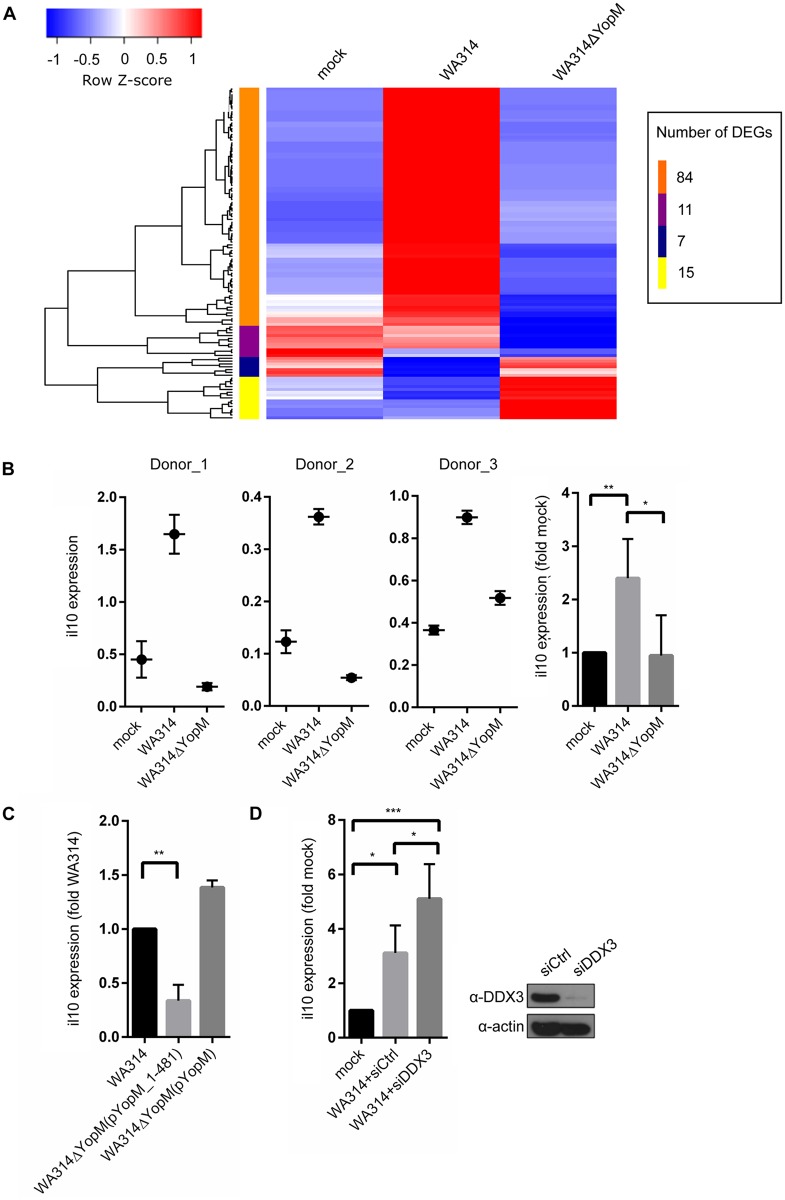
YopM upregulates IL-10 expression in Yersinia infected human macrophages.
A) Heatmap of expression values of differentially expressed genes (DEGs) in human macrophages not infected (mock) or infected with WA314 or WA314ΔYopM. Duplicates (two different donors) of primary human macrophages were infected without (mock) or with Yersinia enterocolitica WA314 or WA314ΔYopM for 6 h. Total RNA was prepared from each sample and subjected to RNA-seq. The scaled expression of each set of replicates, denoted as the row Z-score, is plotted in a red-blue color scale. Red indicates high and blue indicates low expression. Only genes with an absolute log2-fold change greater or equal 2 and p-value smaller or equal 0.01 are shown. These genes were hierarchically clustered (complete linkage) according to their expression profiles. The resulting distinct sets of genes are indicated by the orange-, purple-, blue- and yellow color bar. The number of DEGs in each cluster is indicated. B) Analysis of IL-10 expression in Yersinia infected human macrophages from different donors. Total RNA was isolated from primary human macrophages that were mock infected or infected with WA314 or WA314ΔYopM for 6 h. The RNA was subjected to quantitative RT-PCR using human IL-10 specific primers. IL-10 expression was normalized to expression of three housekeeping genes (GAPDH, TBP, B2M). For each condition triplicate samples of macrophages derived from seven different donors (Donor_1 to Donor_7) were investigated (data from Donor_4 to Donor_7 in S5 Fig). Each bar in graph represents mean ± SD of values from all 7 donors; **p<0.01, *p<0.05. C) Induction of IL-10 expression requires interaction of YopM with RSK. Experimental procedures as in B) with the difference that macrophages were infected with WA314ΔYopM(pYopM_1–481) and WA314ΔYopM(pYopM). Each Bar in graph represents mean ± SD of values from 3 different donors; **p<0.01. D) DDX3 knockdown increases IL-10 expression in Yersinia infected human macrophages. Primary human macrophages were transfected with control siRNA (mock, siCtrl) or DDX3 siRNA (siDDX3 No. 3) for 72 h and not infected (mock) or infected with WA314 for 6 h. Total RNA was subjected to quantitative RT-PCR as in B). Each Bar in graph represents mean ± SD of values from 4 different donors; *p<0.05, ***p<0.001. Western blot verifies DDX3 knockdown in the macrophages.